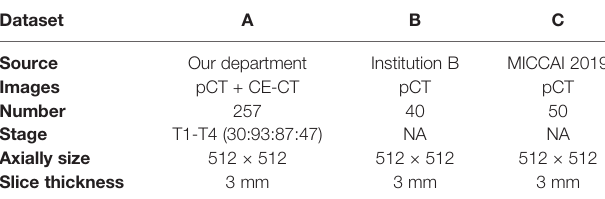
TABLE 1 | Details of the multi-institutional